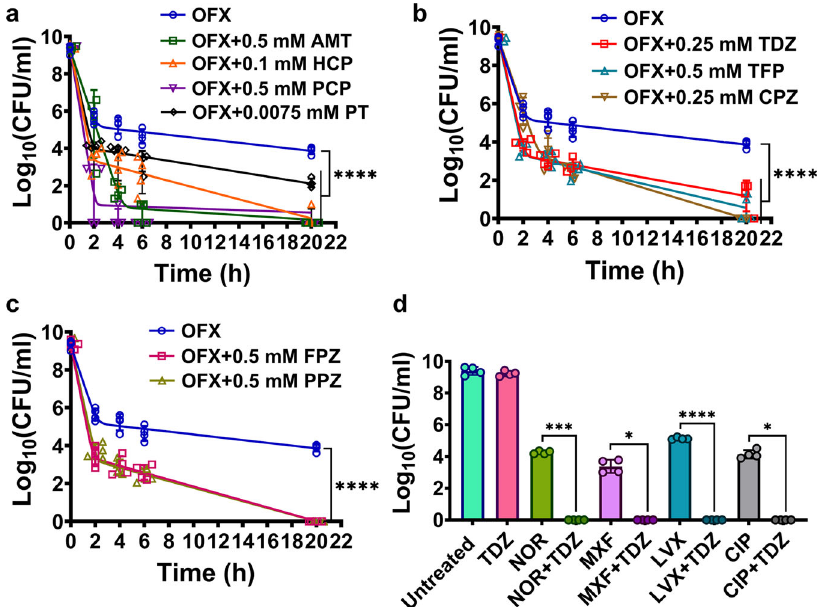
Fig. 2 Identi fi ed chemical hits reduced persister levels in E. coli MG1655 cultures. a – c Biphasic kill curves. Early stationary phase E. coli MG1655 cells, grown in LB, were treated with OFX (5 µ g/ml) and the chemicals at indicated concentrations. Throughout treatment cells were plated for viable cell counts at indicated time points. Of note, the control data (OFX only) is the same in all three panels. TDZ Thioridazine; TFP Tri fl uoperazine; FPZ Fluphenazine; PPZ Perphenazine; CPZ Chlorpromazine; AMT Amitriptyline; HCP Hexachlorophene; PCP Pentachlorophenol; PT Potassium tellurite. n = 4. d Cell survival after quinolone and phenothiazine treatment. Cells ( E. coli MG1655) treated with indicated quinolone and/or phenothiazines for 20 h were plated for viable cell counts. NOR: nor fl oxacin (0.8 µ g/ml); MXF Moxi fl oxacin (0.8 µ g/ml), LVX Levo fl oxacin (0.3 µ g/ml); CIP Cipro fl oxacin (0.2 µ g/ml). n = 4. Statistical analysis was performed using one-way ANOVA with Dunnett ’ s post-test, where * P < 0.05, *** P < 0.001, **** P < 0.0001. Data corresponding to each time point represent mean value ± standard